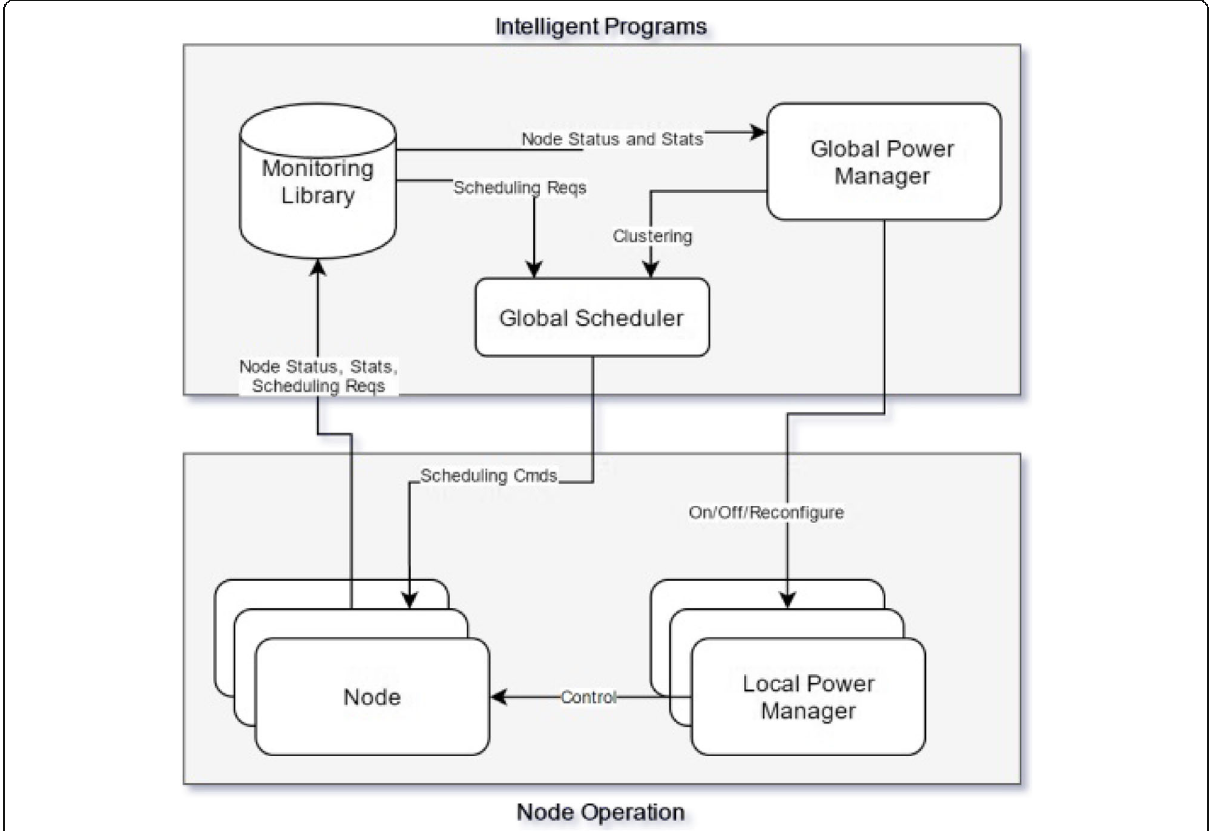
Fig. 7 CoMP Coordinated Scheduling within the reference architecture of Section